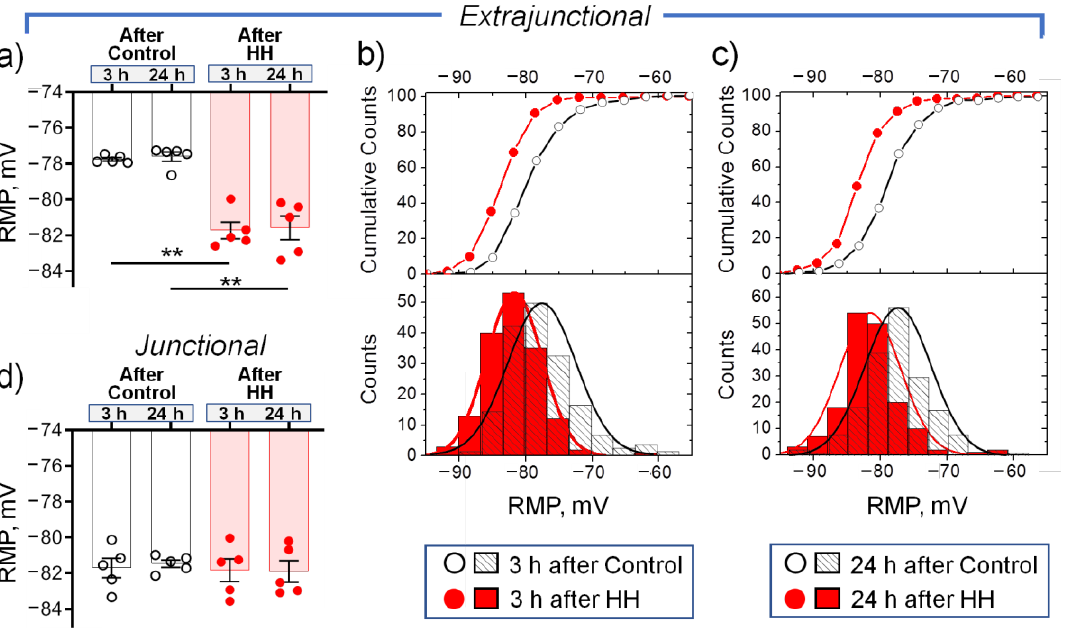
Figure 3. Changes in the resting membrane potential (RMP) of diaphragm muscles isolated from rats subjected to hypobaric hypoxia (HH) at a pressure equivalent to an altitude of 3000 m for 3 h. The measurements were carried out on muscles isolated 3 or 24 h after control or HH treatment in the extrajunctional ( a – c ) and junctional ( d ) sarcolemmal regions. ( a,d ) The number of muscles corresponds to the number of symbols. ( b,c ) Cumulative probability curves and corresponding histograms of RMP distributions 3 ( b ) or 24 h ( c ) after control or HH; the same muscles as in ( a ). The total number of RMP measurements (control/HH): ( b ) 156/159; ( c ) 161/167. Two-way ANOVA followed by Bonferroni multiple comparisons test. ** p < 0.01 — compared to the corresponding control.